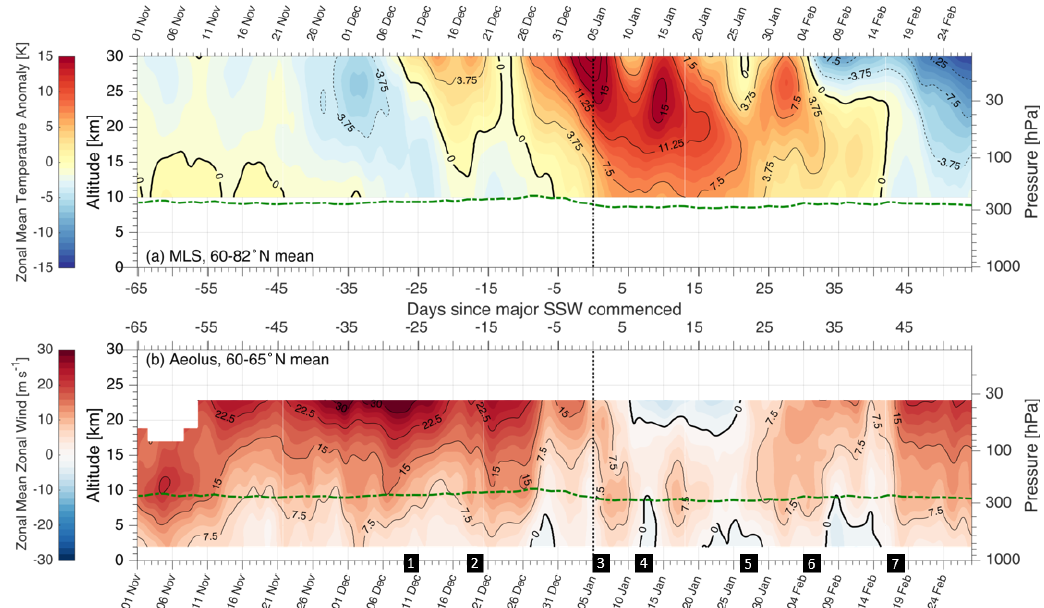
Figure 5. (a) MLS-derived 60–90 ◦ N mean temperature anomalies; (b) Aeolus-derived 60–65 ◦ N mean projected zonal winds for win- ter 2020/21, for altitudes 0–30km. Mean tropopause height derived from ERA5 is shown as a dot-dashed green line. Vertical dotted line indicates the date at which 10hPa winds reversed and the SSW became defined as major. Numbered boxes on the horizontal axis of (b) are used to guide discussion from Sect. 6 onwards. Times are shown as days relative to 5 January 2021 on the centre-figure axes and as dates on the outer-figure axes, with minor ticks indicating a step of